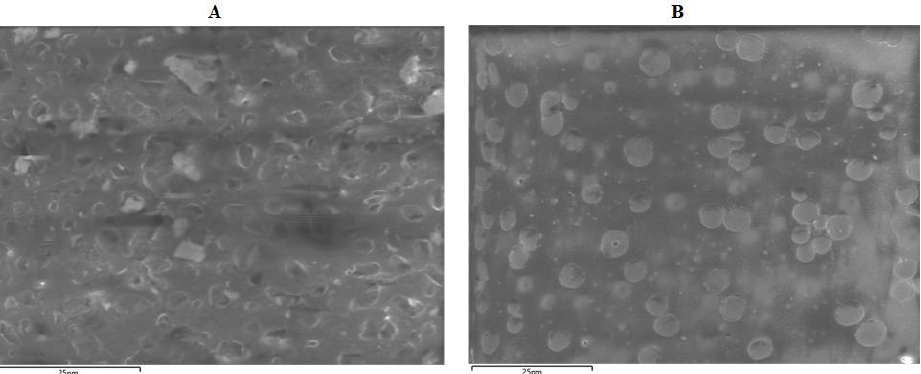
Figure 6. SEM of a polymer matrix (sample PLLA5) — ( A ) and a composite obtained by filling of the matrix with hydroxyapatite (sample PLLA 5 HA) — ( B ). matrix with hydroxyapatite (sample PLLA 5 HA)—( B